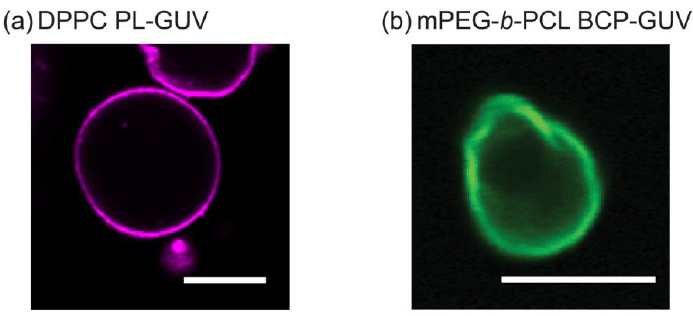
Figure 3. 2D cross-sectional confocal laser scanning microscopy (CLSM) images of ( a ) DPPC giant unilamellar vesicle (GUV) (Scale bar: 20 µ m) and ( b ) mPEG- b -PCL GUV (Scale bar: 10 µ m). The substances 16:0 Liss Rhod PE and (mPEG- b -PCL)-FITC were used to tag phospholipid (PL)-GUVs and amphiphilic block copolymer (BCP)-GUVs, respectively. RL-Rhod B fluorescence in magenta (excitation laser at 561 nm / detection wavelength 550–700 nm) and RL-FITC fluorescence in green (excitation laser at 488 nm / detection wavelength 400–571 nm). Both images were obtained on a Plan- Apochromat 20 ×/0.8 M27 objective lens. These GUVs encapsulated 100 mM sucrose buffer and were suspended in iso-osmolar solution of 100 mM glucose to lower the mobility during microscopic